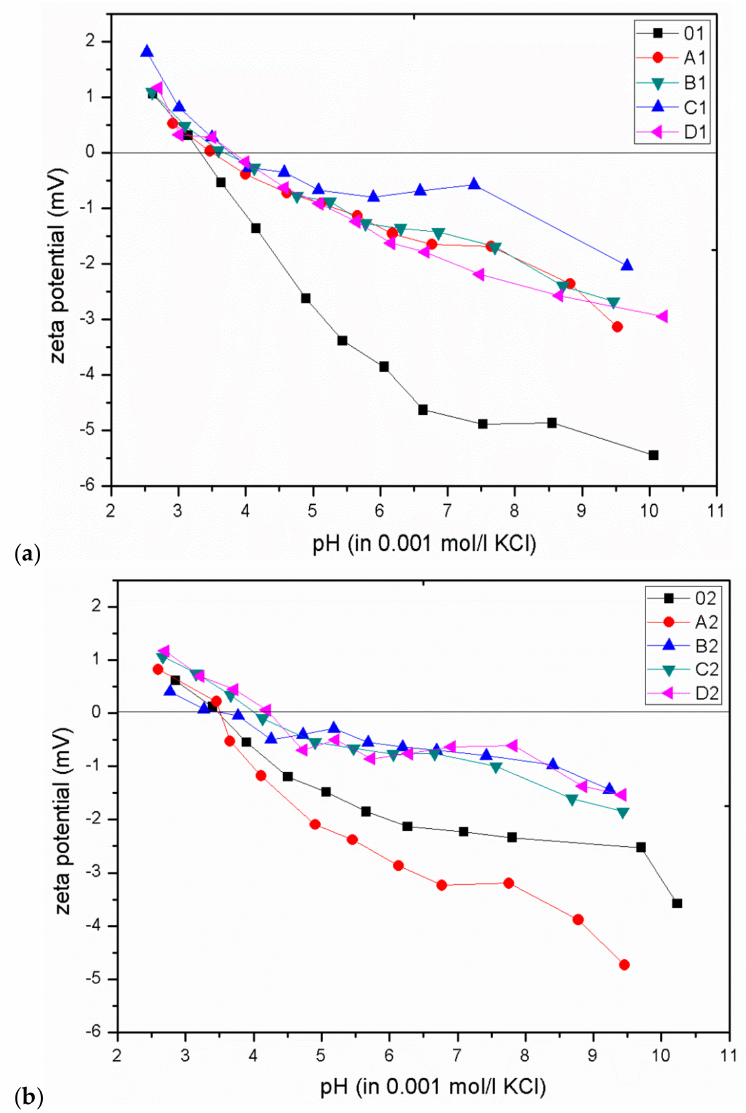
Figure 9. The dependence of the zeta potential on the pH value for CEL and GO/CEL fibres coagulated in water ( a ) and methanol ( b ). Straight line designates the isoelectric point (IEP) (where ζ = 0